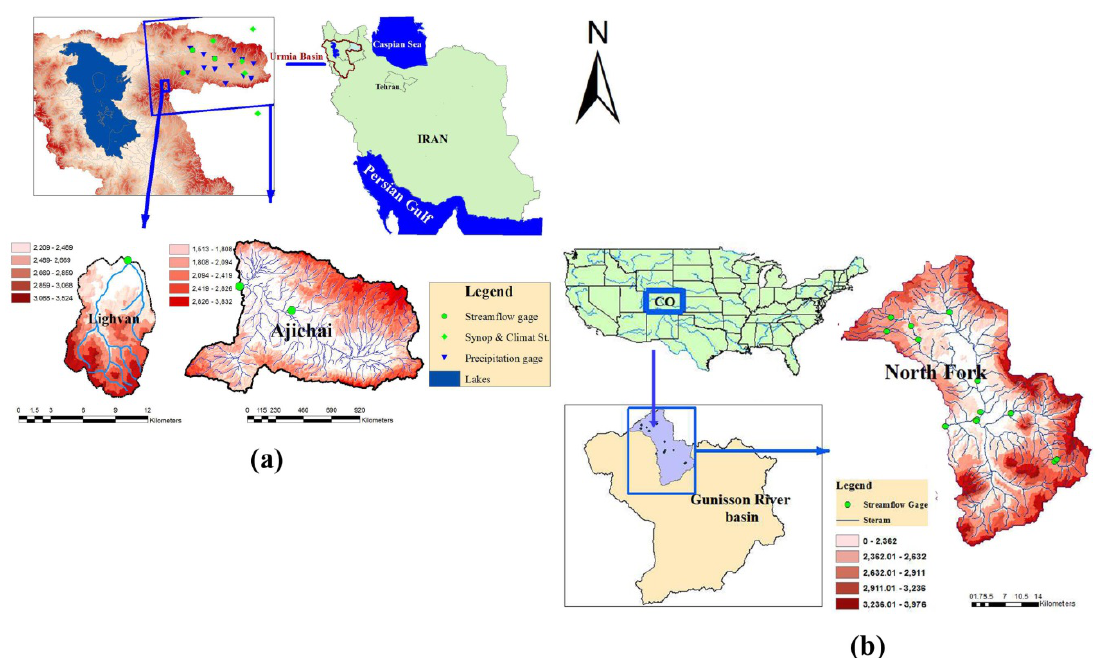
Figure 4. Map of study area: ( a ) Ajichai and Lighvan basins located in East Azerbaijan province, Iran; and ( b ) North Fork Gunnison River, in Colorado, USA. Table 2. Geophysical and climatological characteristics of the basins.